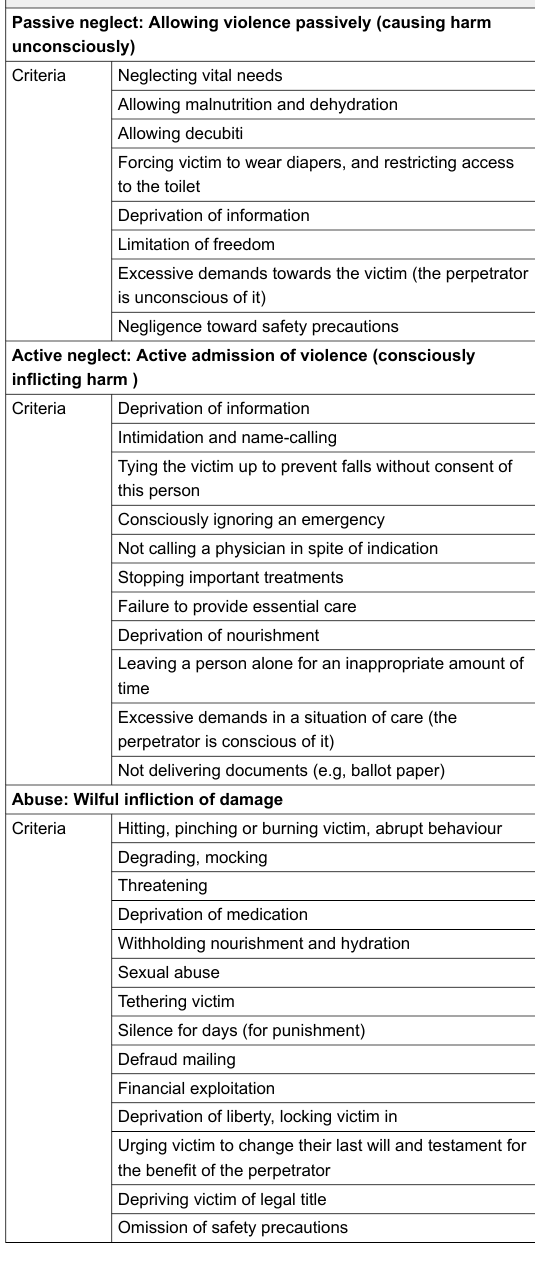
Table 1: Definitions and